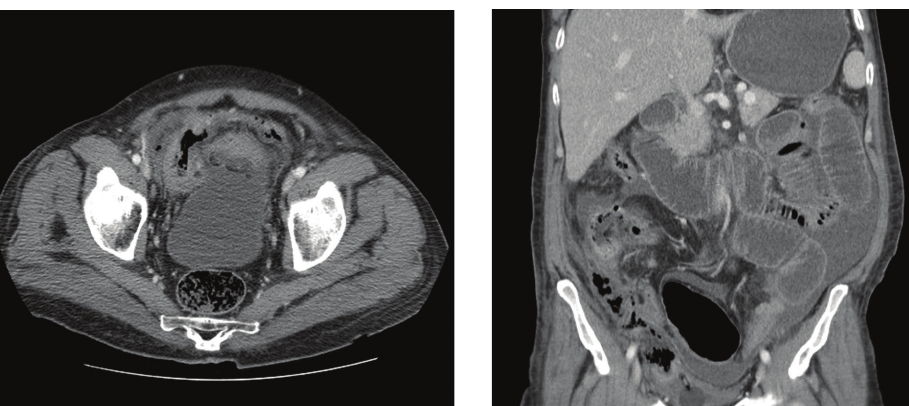
Figure 4: Control computed tomography scan of the abdomen showed necrosis of the bladder wall, predominantly the bladder dome and right bladder wall, with associated peritonitis